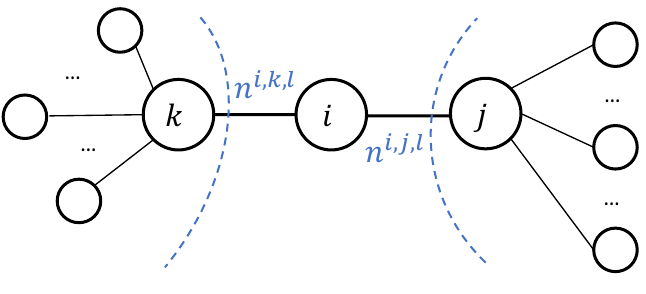
Figure 1. Proxies in the Message Exchange Network: for constraint l , user i announces n i , k , l as a summary of demands for the tree on the left of i (starting from k ) and n i , j , l as a summary of demands for the tree on the right of i (starting from j